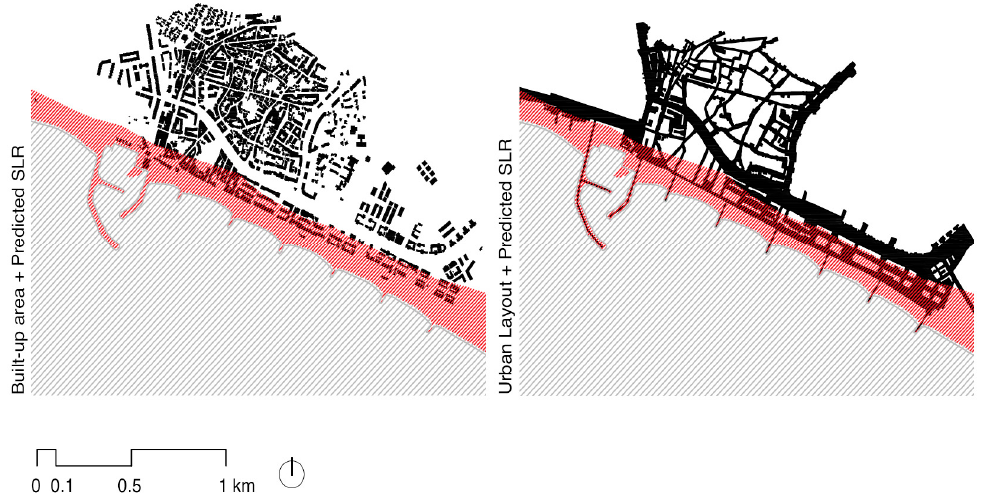
Figure 6. Quarteira. Urban layout overlaid with the projected sea level rise scenario for 2100 based on [6]. In red, urban areas vulnerable to rising mean sea level are identified. Cartographic bases provided by Câmara Municipal de Loulé. Authors’ edition, 2022.